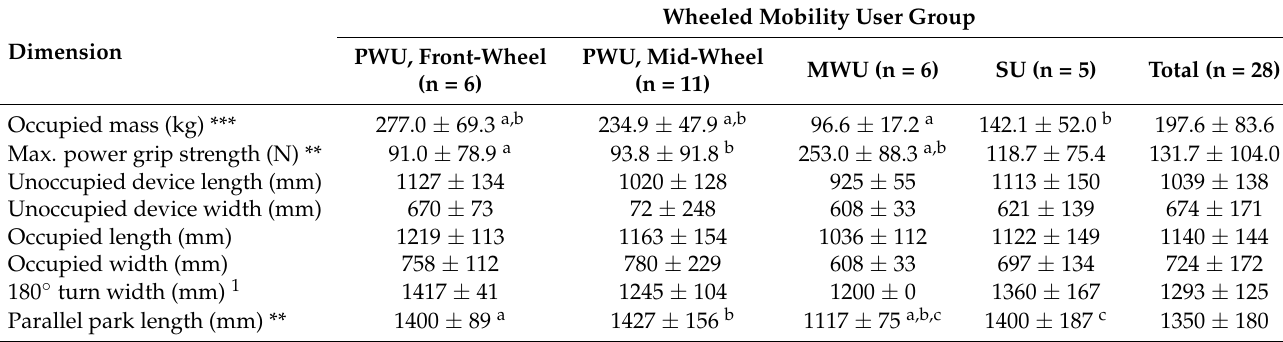
Table 4. Mean ± SD values for occupied mass (kg), maximum power grip strength (N), unoccupied device length and width (mm), occupied length and width (mm), minimum parallel park length (mm), and minimum 180 ◦ turn width (mm) stratified by wheeled mobility user group (n =